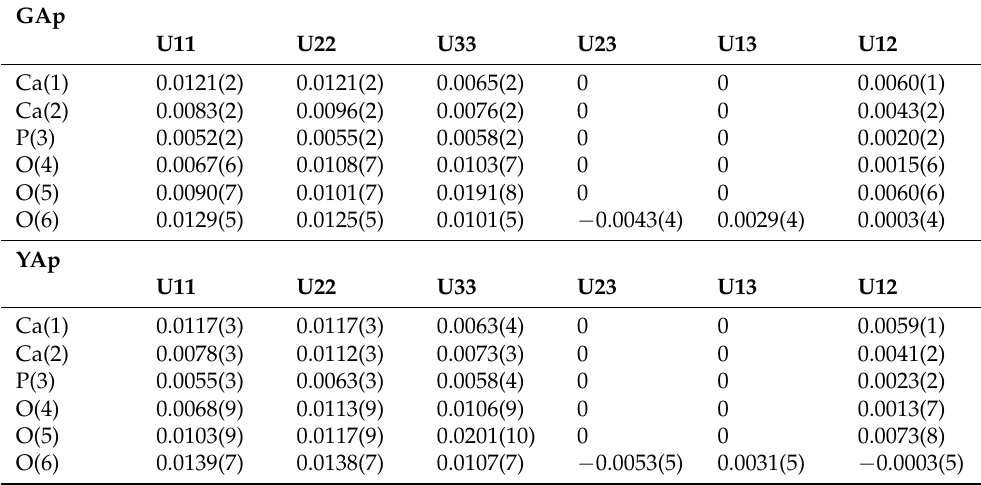
Table A4. Anisotropic displacement parameters Uij (Å 2 ). T = exp{ − 2 π 2 [ h 2 a* 2 U11 + . . . + 2 h k